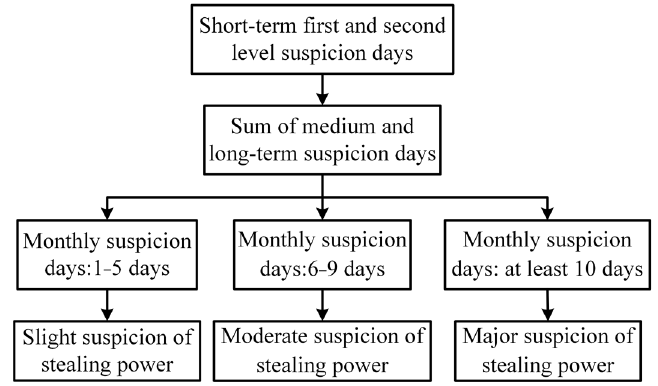
Figure 3. Flowchart of medium- and long-term power-stealing determination.